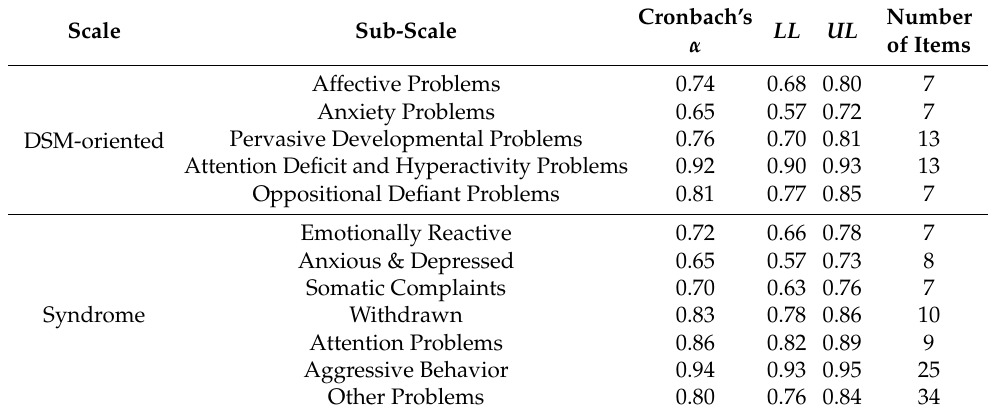
Table 2. Internal consistency for the